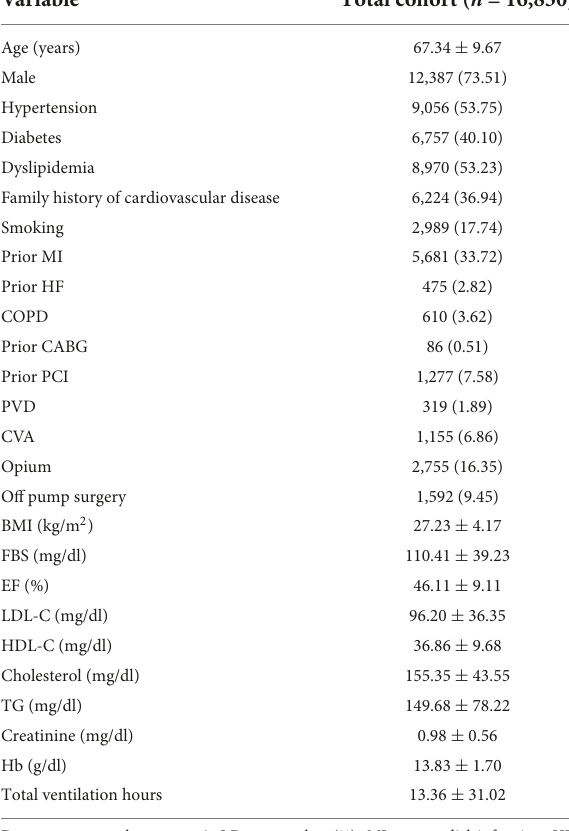
TABLE 1 Baseline and hospitalization characteristics of the study cohort.